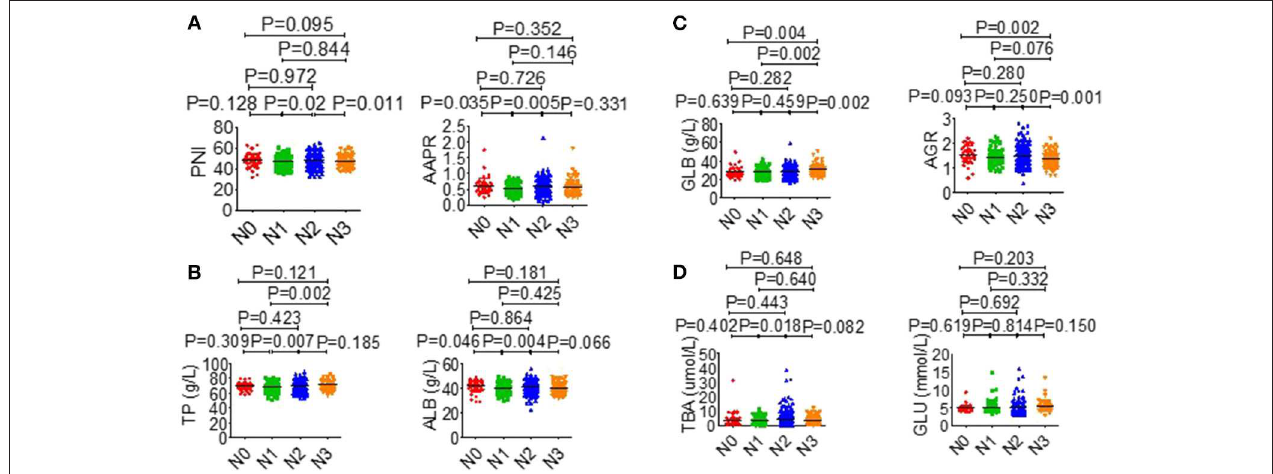
FIGURE 5 | Effects of N stage on serological parameter. (A) PNI (left), AAPR (right). (B) TP (left), ALB (right). (C) GLB (left), AGR (right). (D) TBA (left), GLU (right).